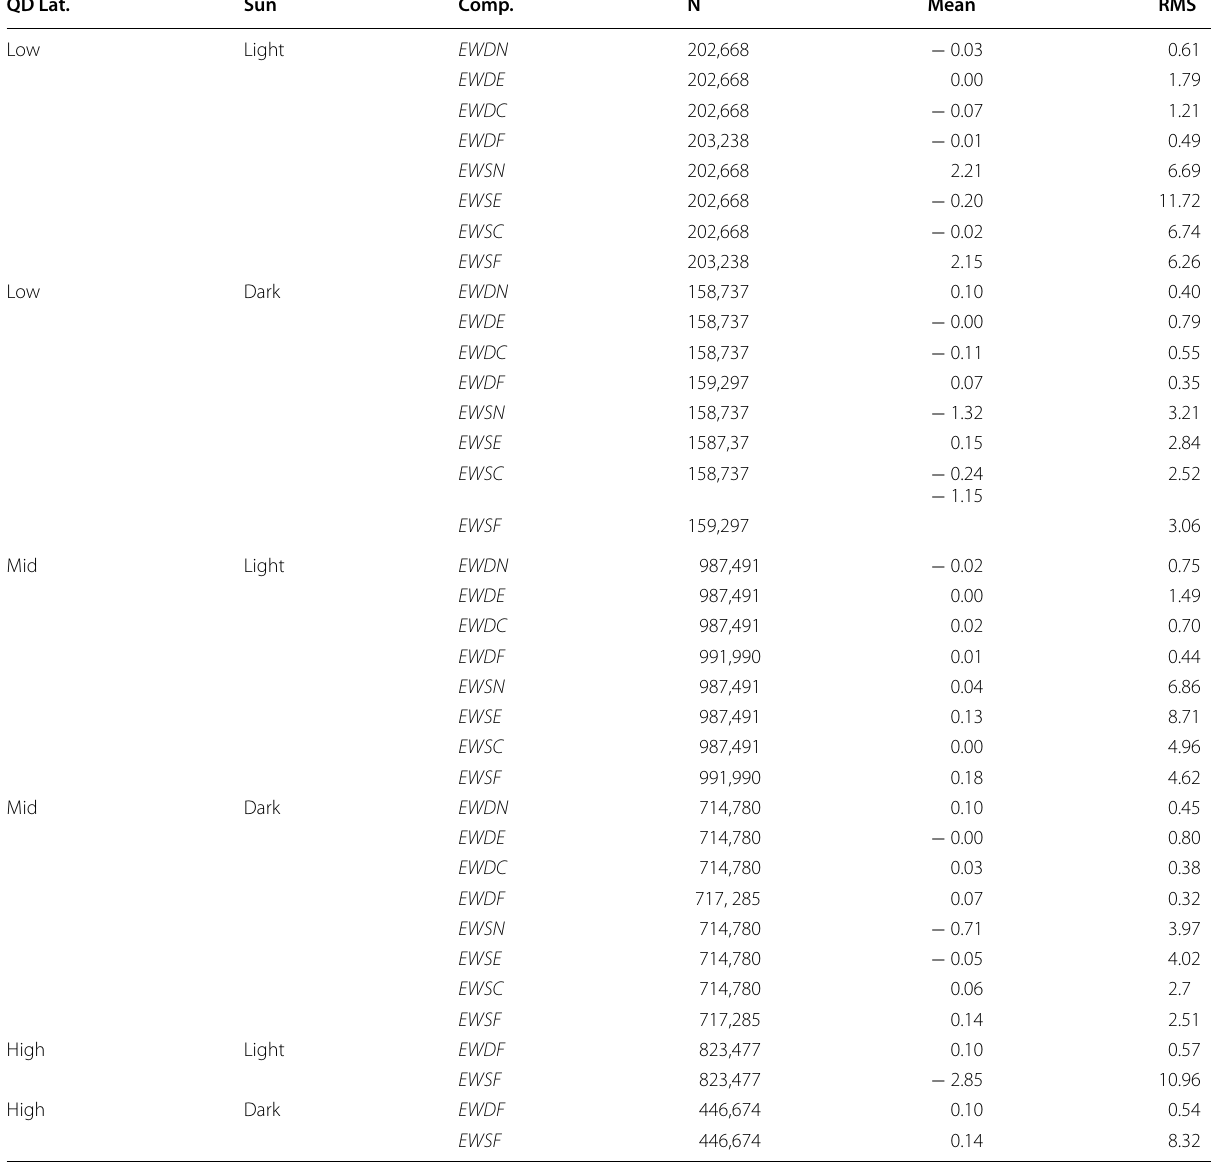
Mean and RMS are in units of “nT”